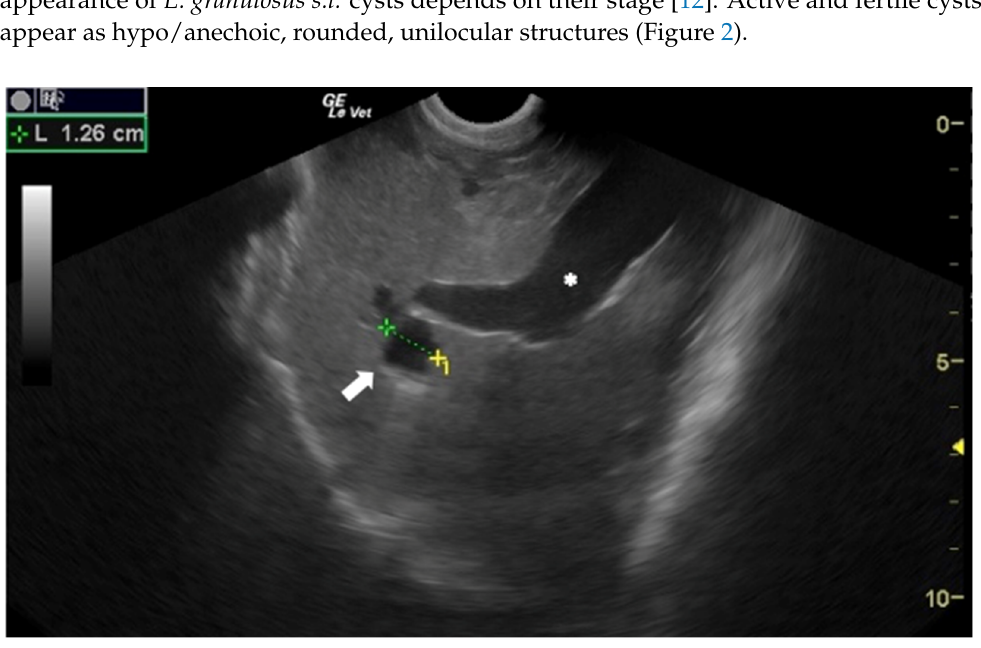
Figure 2. Sheep liver with a unilocular, rounded, anechoic E. granulosus cyst (arrow). Portal vein (*). Courtesy of the Veterinary Teaching Hospital, University of Sassari (Italy).